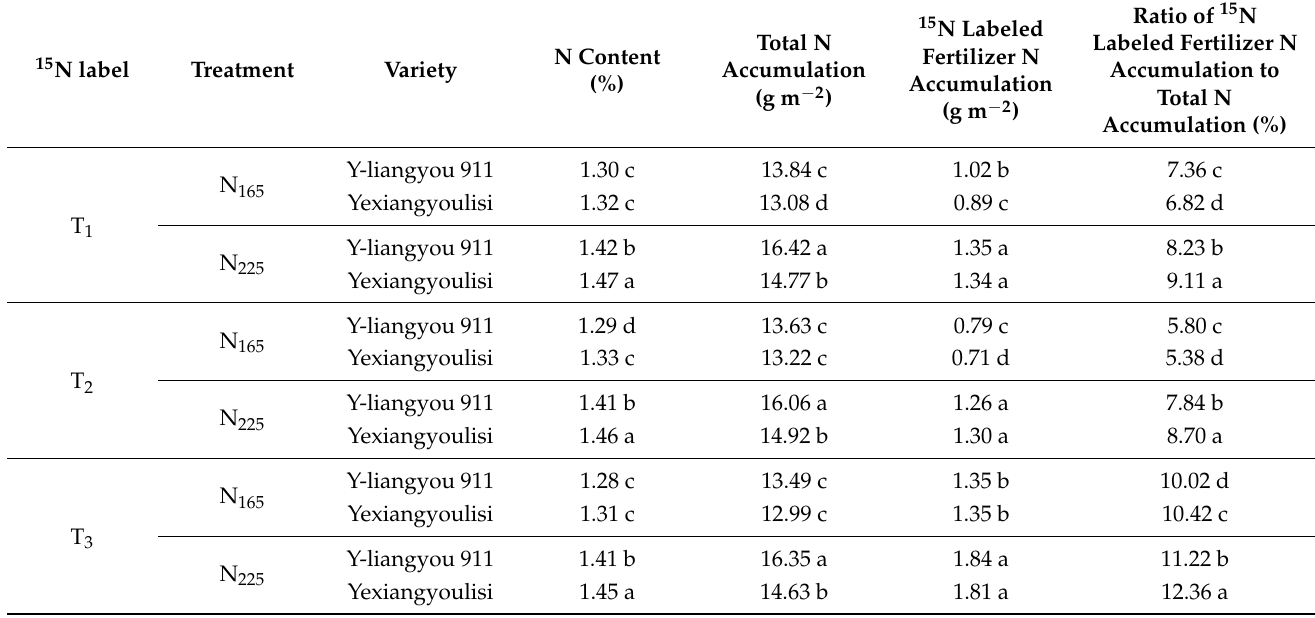
Table 5. Effects of N application rates on grain N accumulation in high-quality rice varieties.